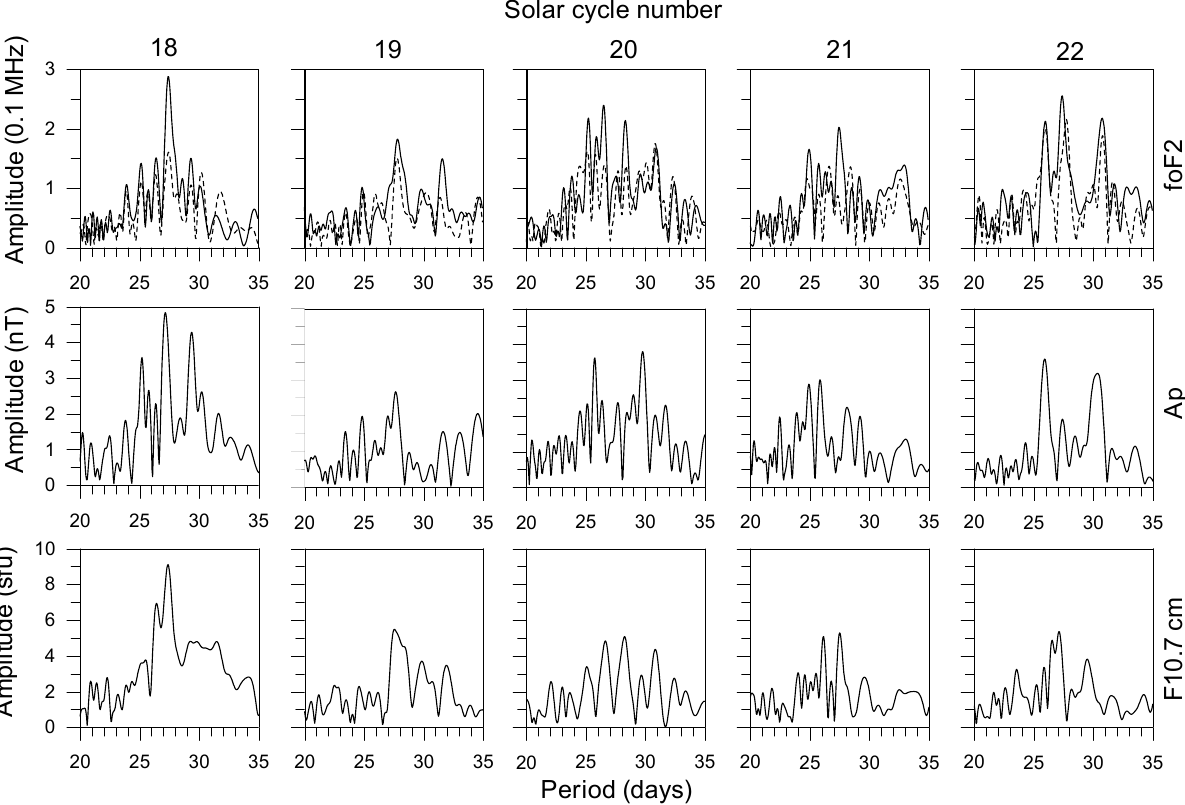
Fig. 2. Amplitude spectra of fo F2 (Moscow), A p and F10.7cm in the period range from 20 to 35 days over 4-year intervals in the late declining phase of solar cycles 18–22 before sunspot minima. The thick and dashed lines mean midday and midnight fo F2 spectra,